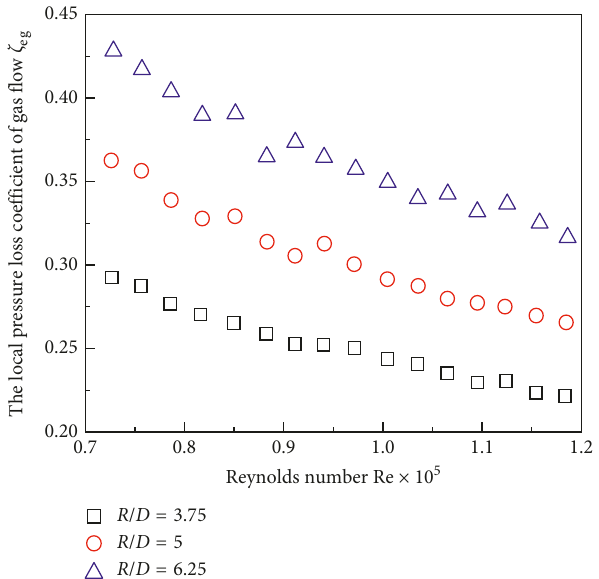
Figure 6: Relationships between local pressure loss coefficient (only airflow) and Reynolds number for the different bend